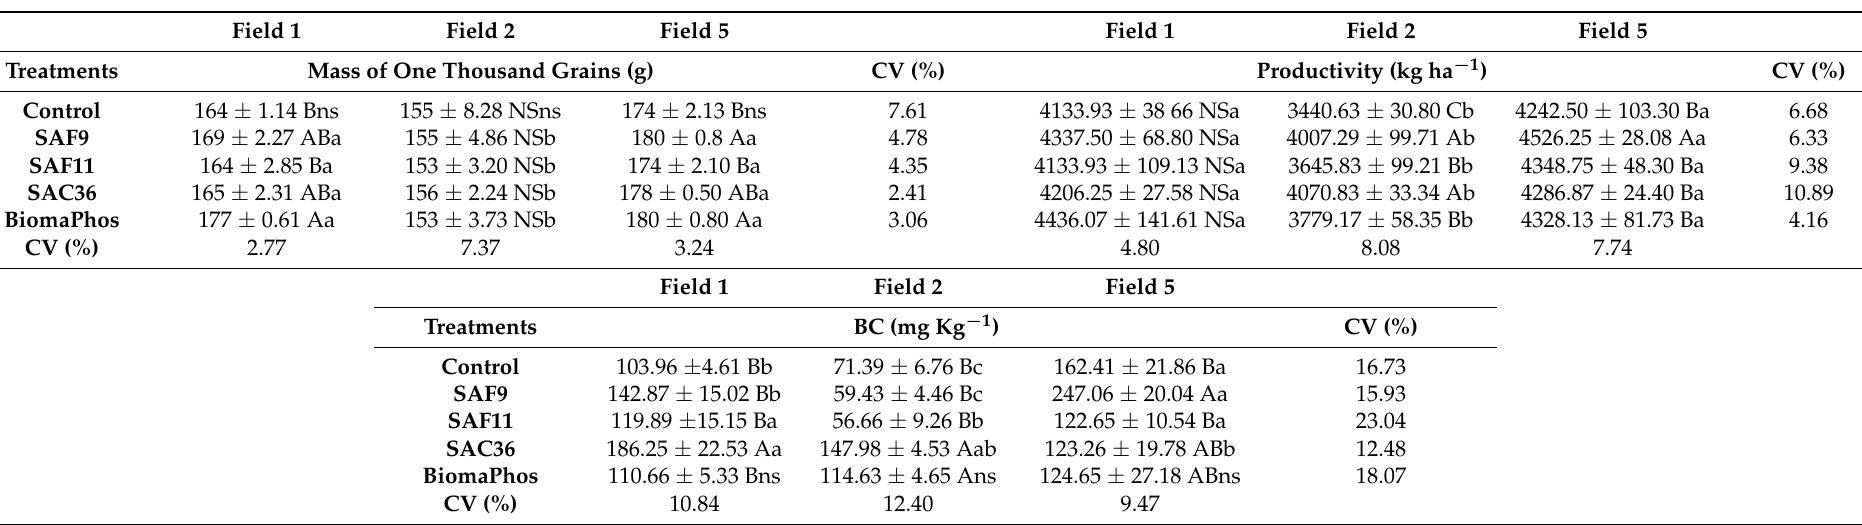
Table 4. Effect of inoculation with plant=growth-promoting rhizobacteria on thousand-grain mass, yield, and microbial biomass carbon (MBC) sampled in the soil of Glycine max L. plants grown in summer 2019/2020, in three experimental fields of soybean cultivation in the interior of the state of Goi á s, Brazil, with